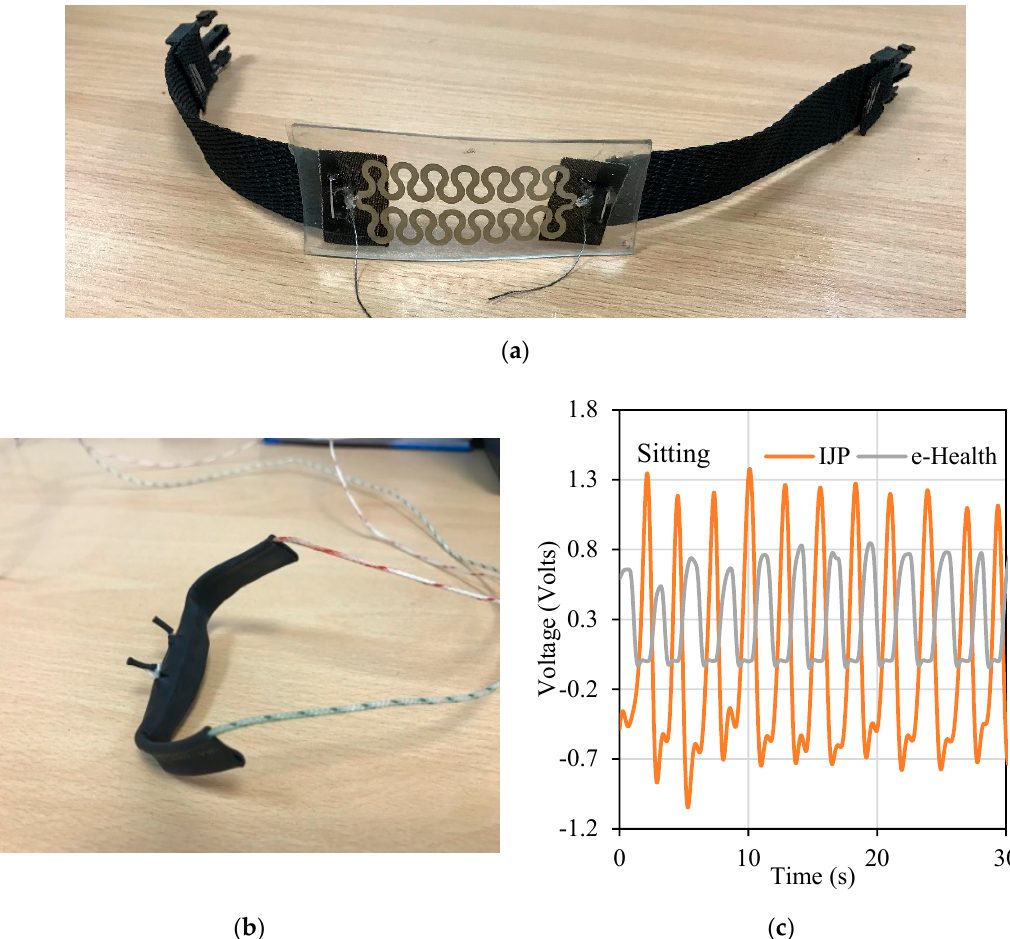
Figure 1. ( a ) The Inkjet printing (IJP) respiration rate (RR) sensor. ( b ) The reference e-Health RR sensor. ( c ) The derived respiratory signals in 30s.